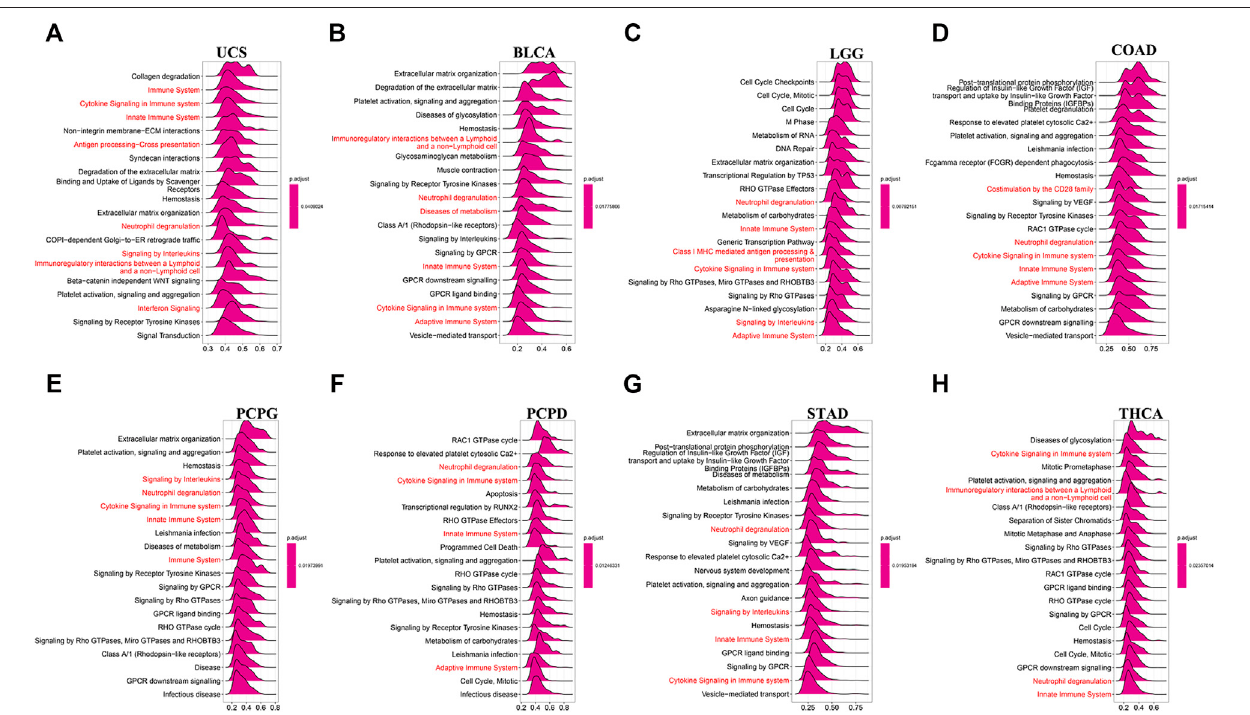
FIGURE 6 | C1QTNF6 ’ s GSEA results in TCGA pan-cancer. (A – H) The most 20 related pathways of GSEA are presented in the form of a mountain map, and immune-related pathways are marked in